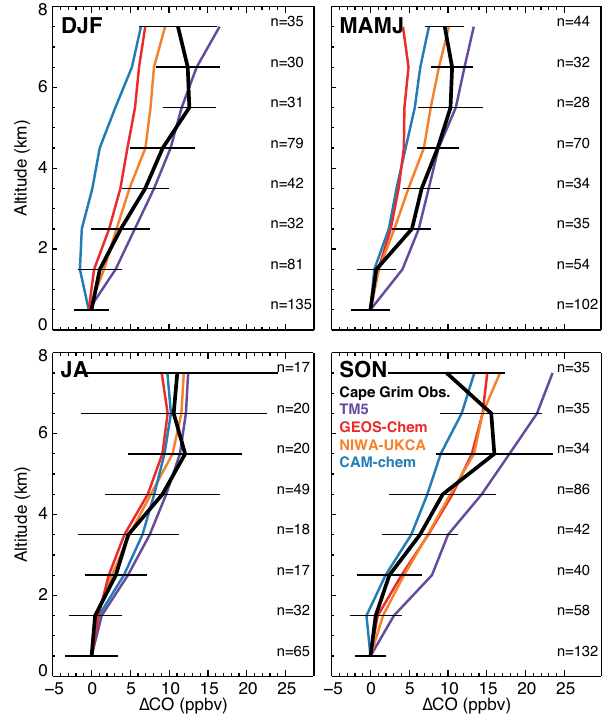
Figure 5. Median CO vertical profiles observed from 1991–2000 during CGOP (black) and simulated for 2004–2008 by TM5 (pur- ple), GEOS-Chem (red), NIWA-UKCA (orange), and CAM-chem (blue) in the Cape Grim background region (see Fig. 2). Profiles are shown as (cid:49) CO, the deviation (in ppbv) from the observed or mod- eled value in surface air in each season. Thin horizontal lines show the observed median absolute deviations across all years. The num- ber of observed data points in each seasonal altitude bin is given at the right of each